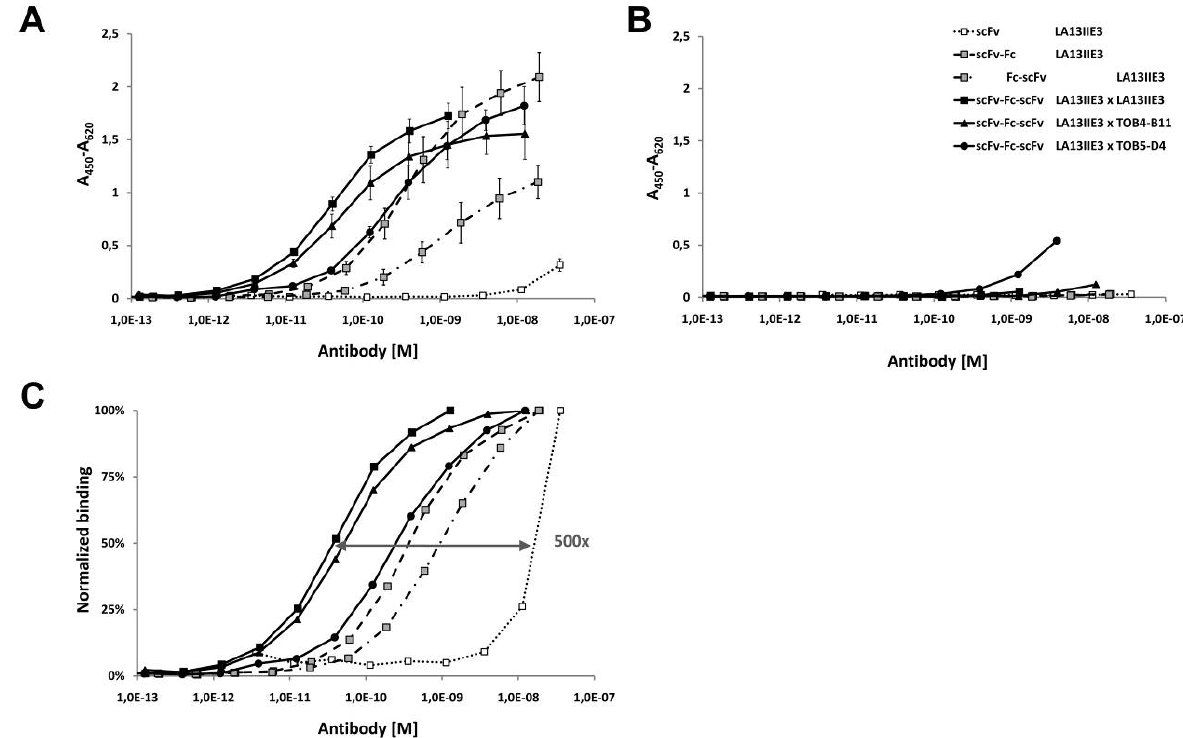
Figure 6. Avidity effects. ( A ) Monovalent scFv (LA13-IIE3, dotted line), bivalent scFv-Fc and Fc-scFv (LA13-IIE3, dashed lines), as well as tetravalent scFv-Fc-scFv antibodies (LA13-IIE3 × LA13-IIE3, LA13-IIE3 × TOB4-B1, and LA13-IIE3 × TOB5-D4; solid lines) were incubated with serial dilutions in CRP coated ELISA wells. ( B ) PhOx-BSA was used as negative control antigen. ( C ) In order to determine the 50% effective concentration (EC of CRP binding, absorbances were normalized to the maximum value measure for each construct. Detection of the scFv was done with the mouse α -myc-tag monoclonal antibody (Myc1-9E10) and a mouse IgG specific secondary antibody conjugate whereas scFv-Fc, Fc-scFv and the scFv-Fc-scFv antibodies were detected with an anti-human IgG (Fc-specific) antibody conjugate. The scFv domains and their position regarding the Fc moiety are indicated for each construct.